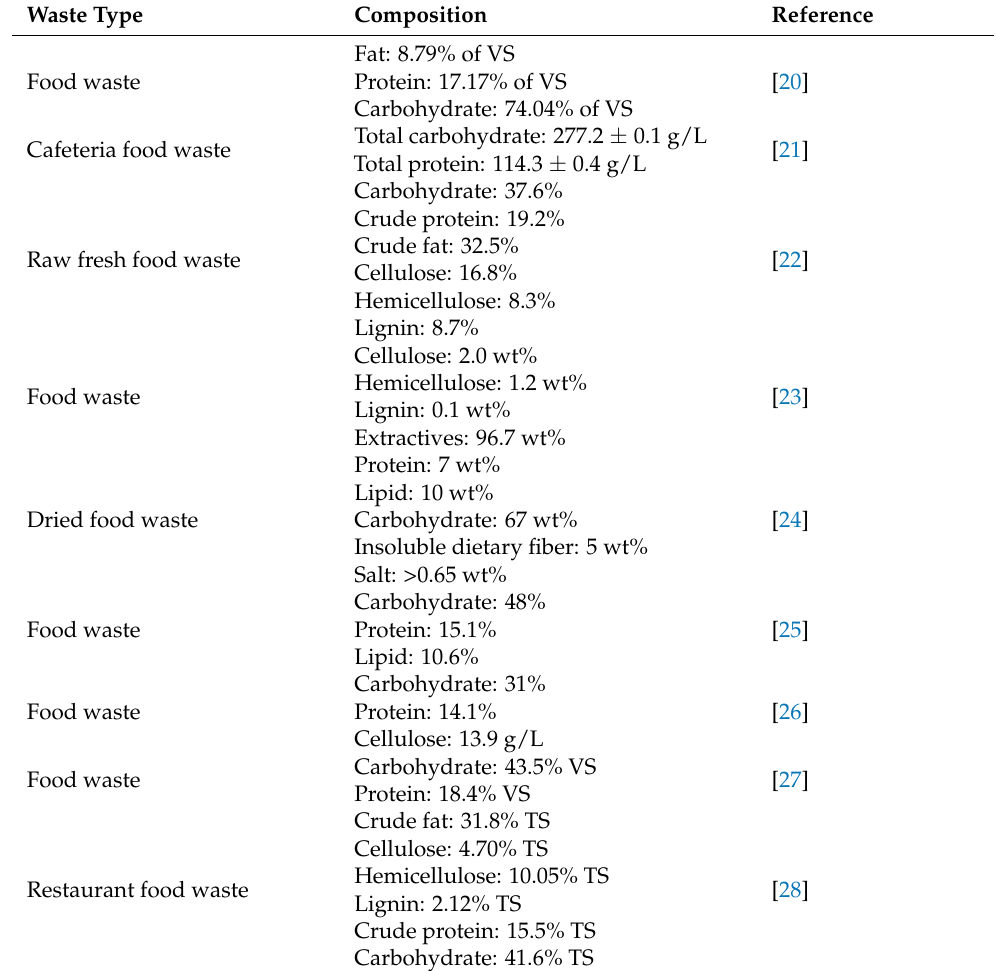
Table 1. Composition of food